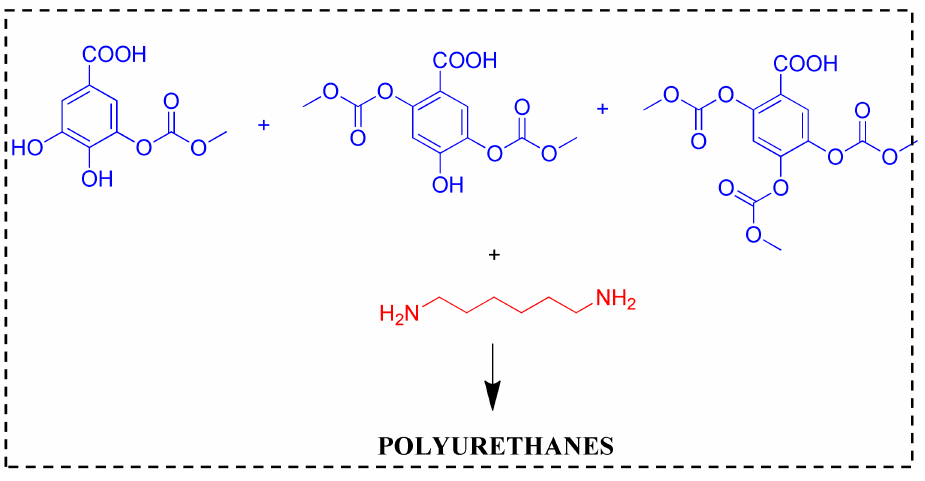
Figure 5. The second reaction between major preconceived products with hexamethylenedi- amine